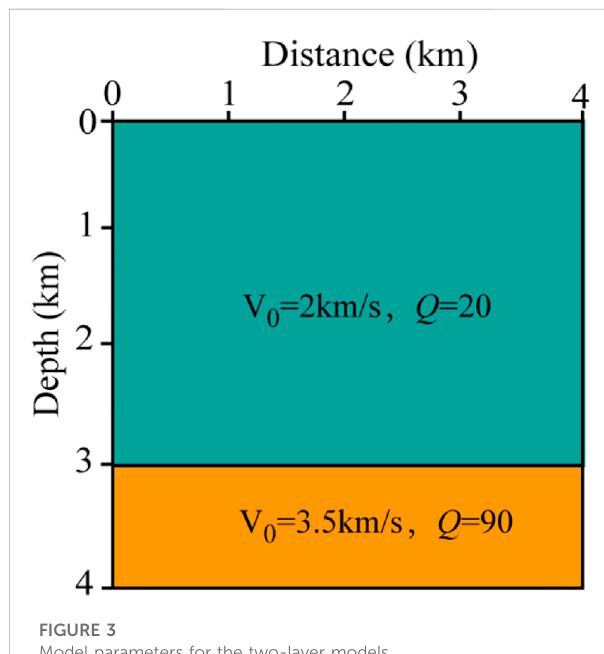
FIGURE 3 Model parameters for the two-layer